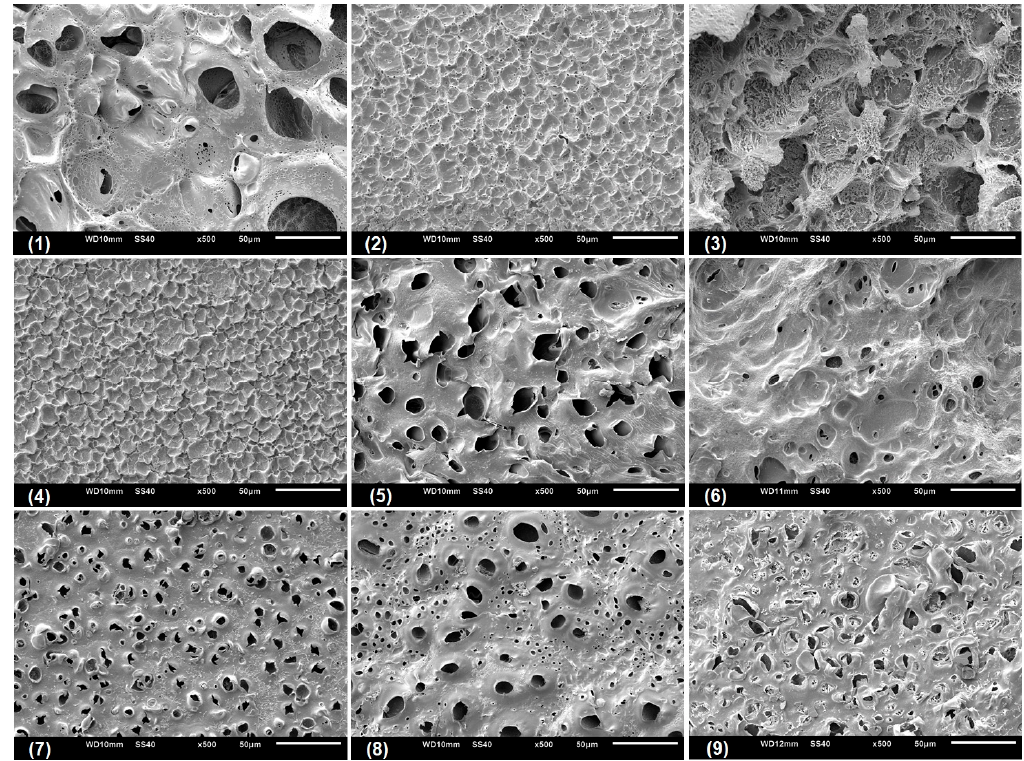
Figure 7. Scanning electron micrographs of CGP/PVA films swollen in glycine buffer (pH 9.5). Table 3. Distribution and relative frequencies for pore size of each CGP/PVA film produced using the 3 3-1 fractional factorial design.